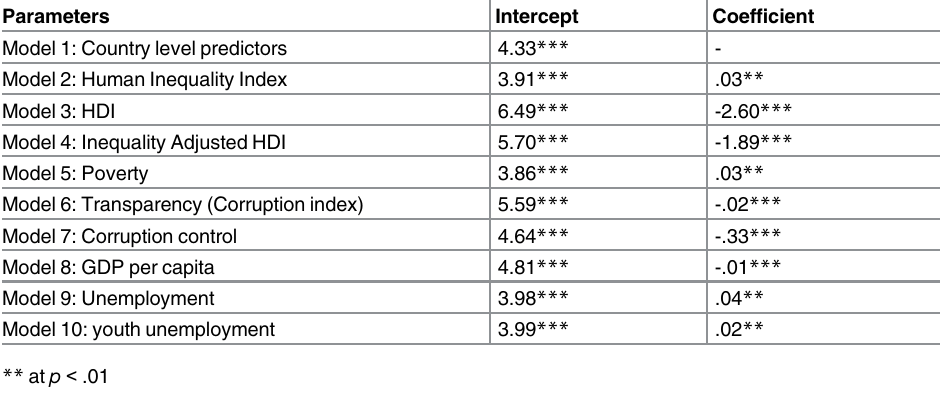
Table 6. Multilevel regressions predicting